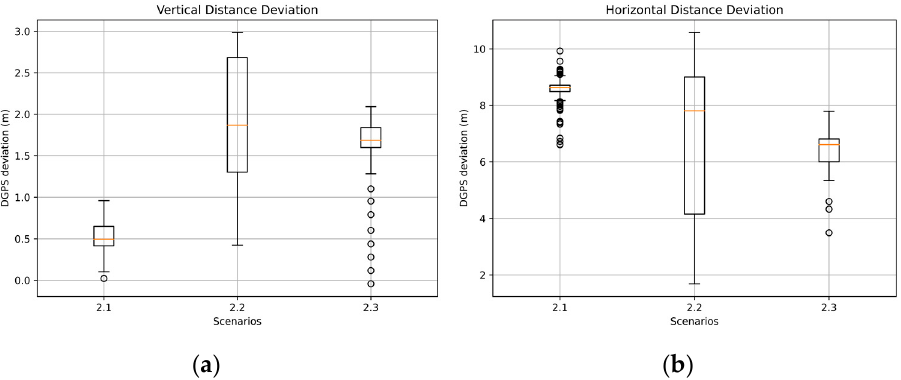
Figure 16. Vertical (( a ), left) and horizontal (( b ), right) deviations between DGPS sensor and Refer- ence Points.